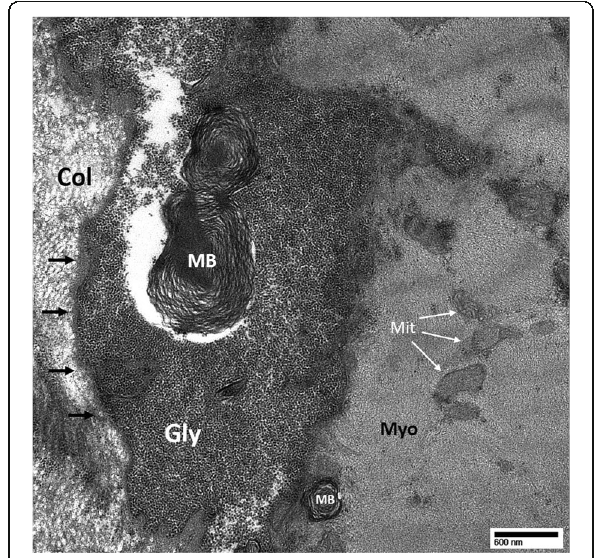
Fig. 2 Transmission electron microscopy of the frozen endomyocardial biopsy tissue. There is marked cytoplasmic glycogen accumulation and occasional myelin bodies of various sizes. Gly=glycogen; MB=myelin body; Myo=myofibril; Mit=mitochondria; Col=extracellular collagen; black arrows denote cell